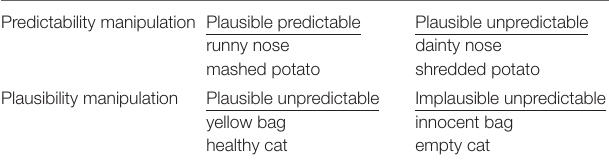
TABLE 1 | Example items in the Lau et al.